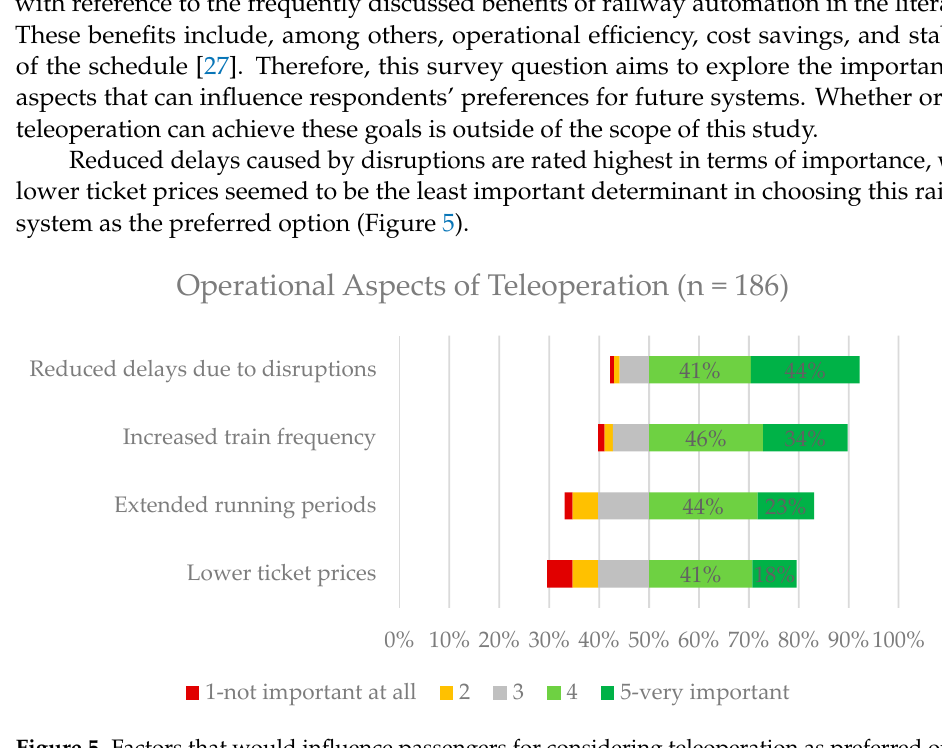
Figure 4. Importance of rail personnel for rail operations.